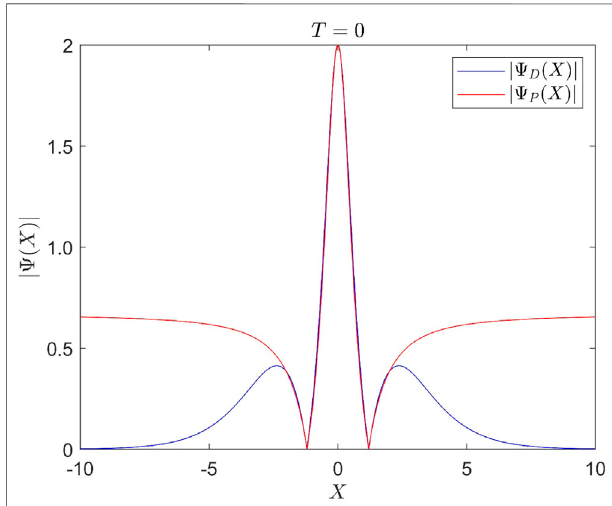
FIGURE 2 | The amplitude rescaled Peregrine breather envelope shape vs. degenerate two-soliton solution pro fi le at T (cid:2) 0.